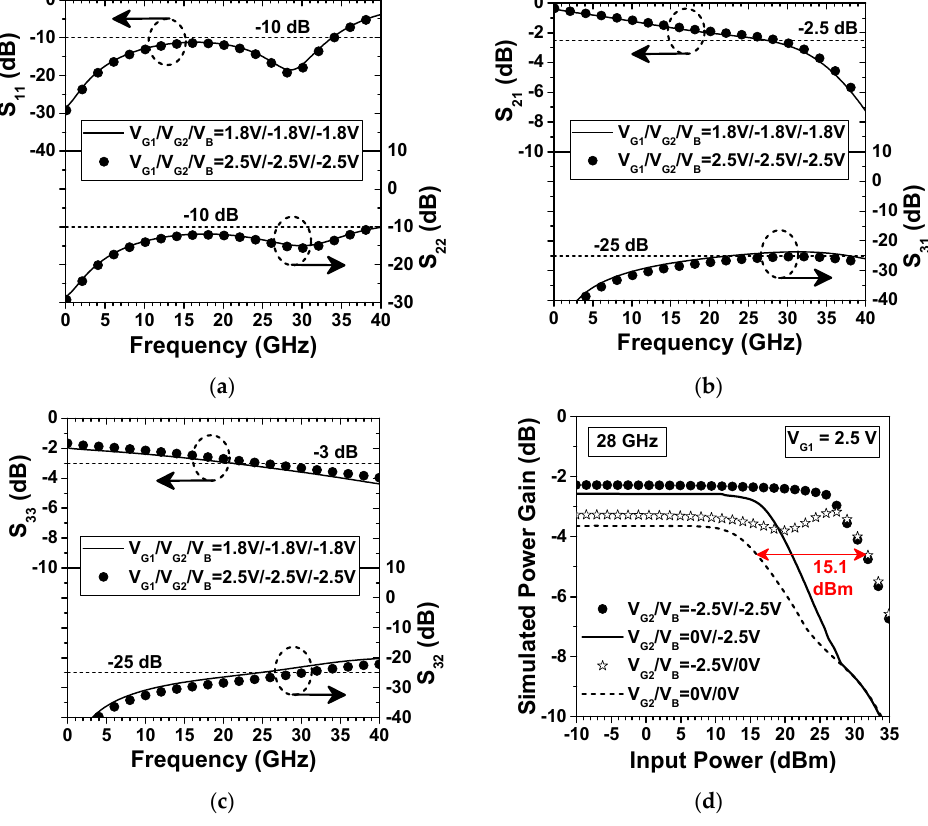
Figure 3. Simulated ( a ) S 11 and S 22 ; ( b ) S 21 and S 31 ; ( c ) S 33 and S 32 ; and ( d ) IP 1dB of the SPDT switch.